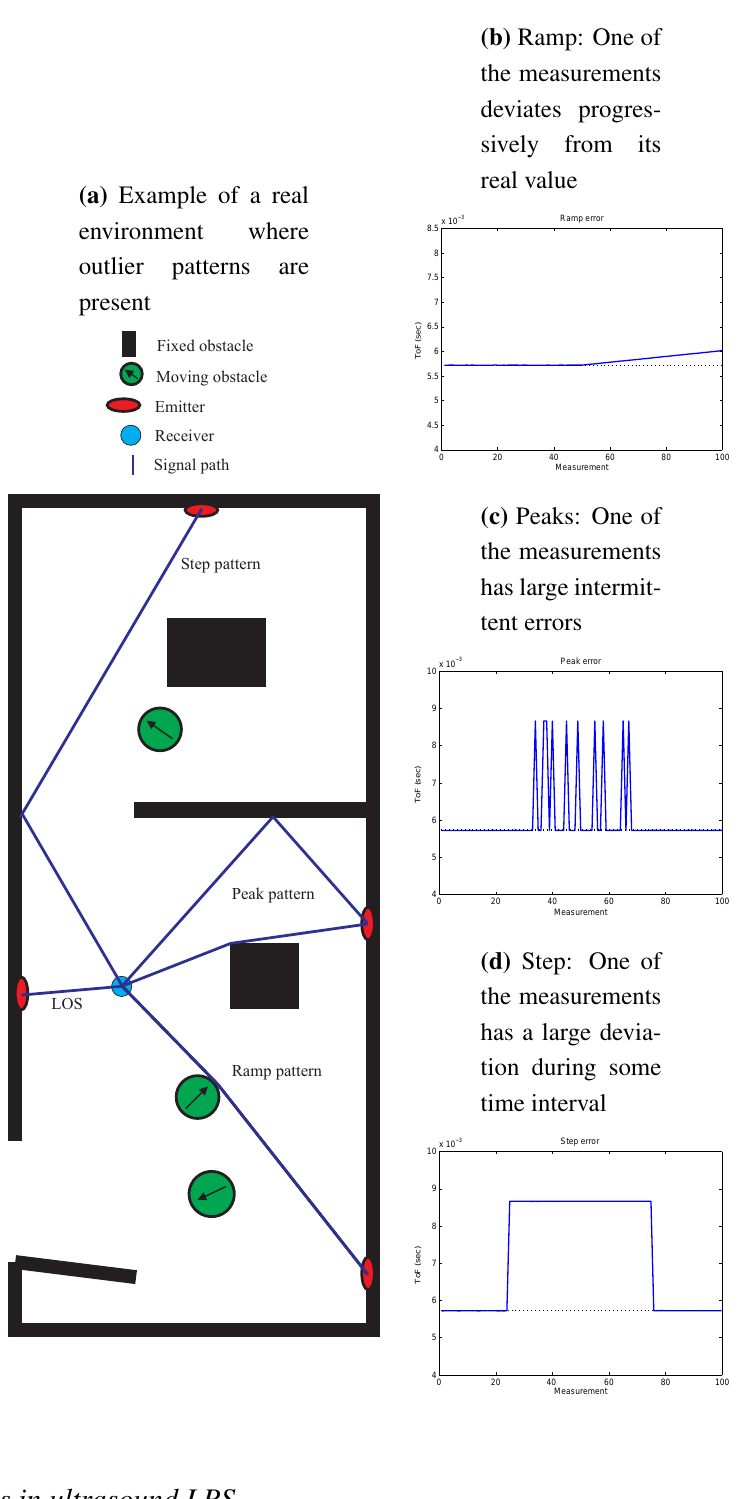
Figure 3. Outlying patterns considered in the evaluation of the